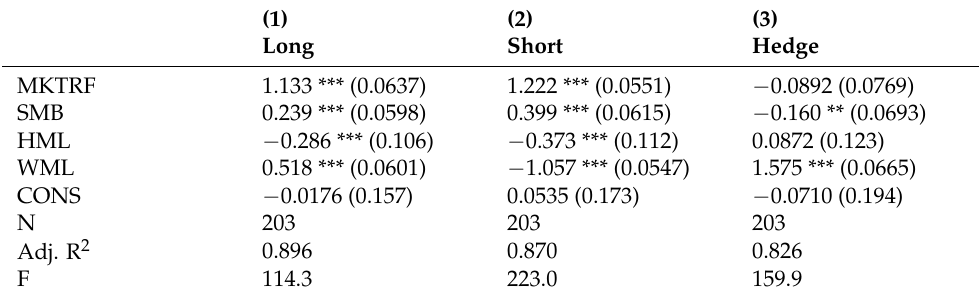
Table 7. Low EPU and four factor asset pricing